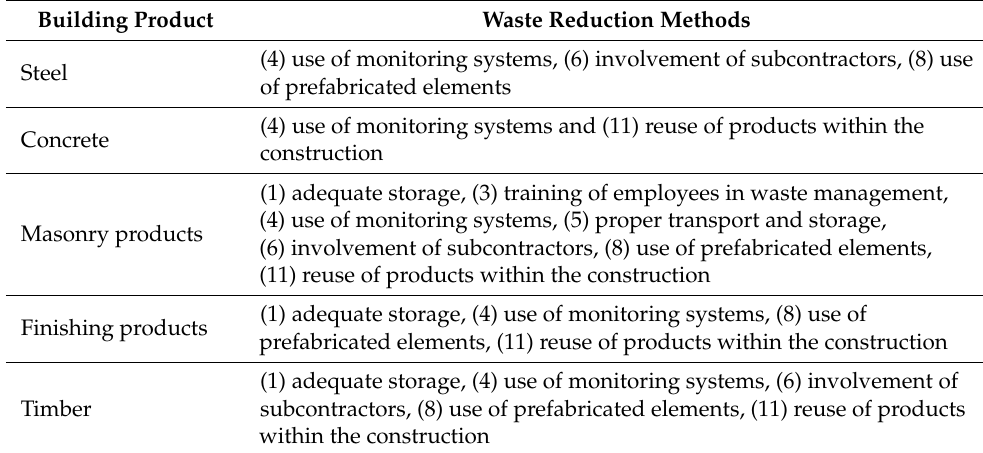
methods usage in relation to five groups of construction products and the size of a